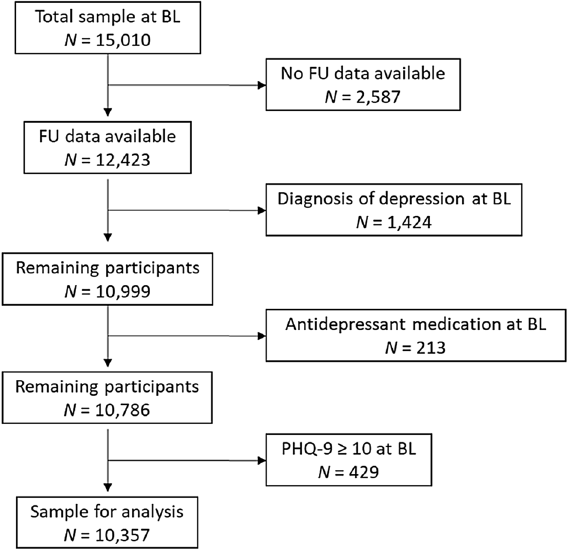
Figure 1. Participant flow. The present work is based on a community sample of N = 10,357 participants who took part in assessments at two measurement points and had no evidence for depression at baseline. BL baseline, FU